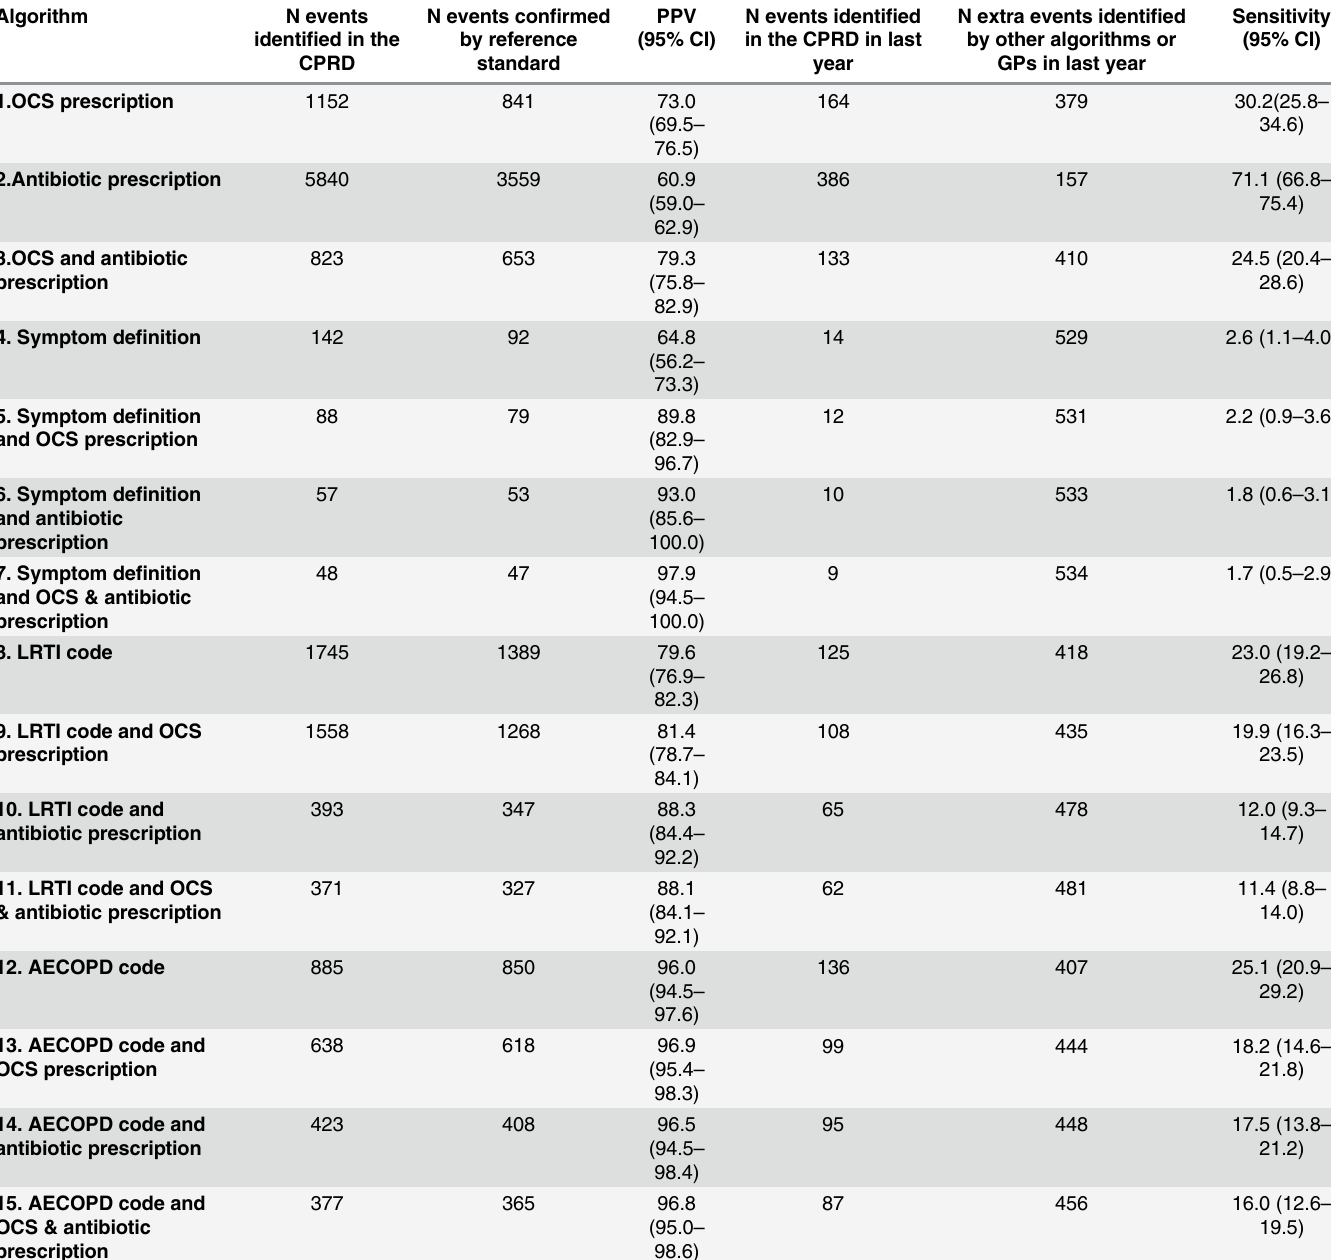
Table 4. PPV and sensitivity for the